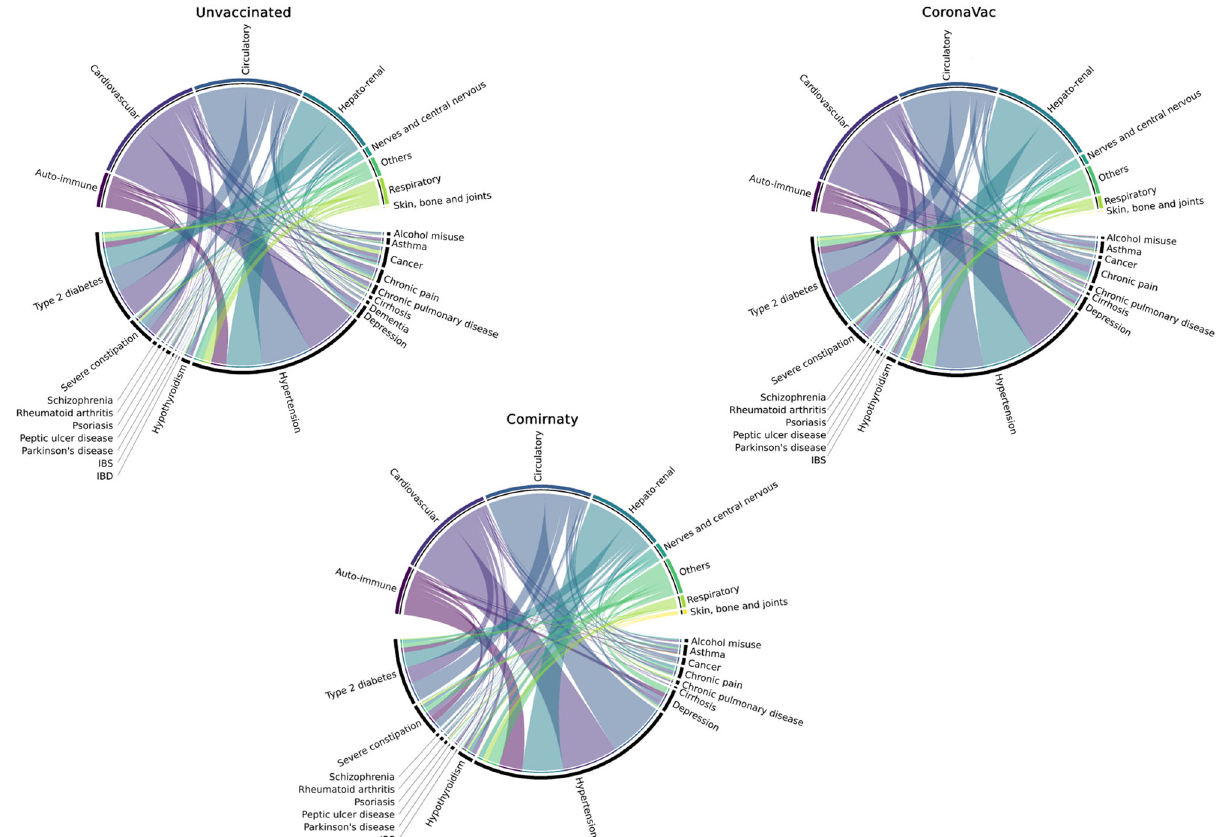
Fig. 3 Chord diagrams showing the relative frequencies of the co-occurrence of speci fi c chronic disease (lower arc) and speci fi c adverse events of special interest (upper arc) by vaccine group. The larger the area of the chord linking between a chronic condition and an adverse event of special interest, the more frequently observed the co-occurrence of them. IBS irritable bowel syndrome, IBD in fl ammatory bowel disease.